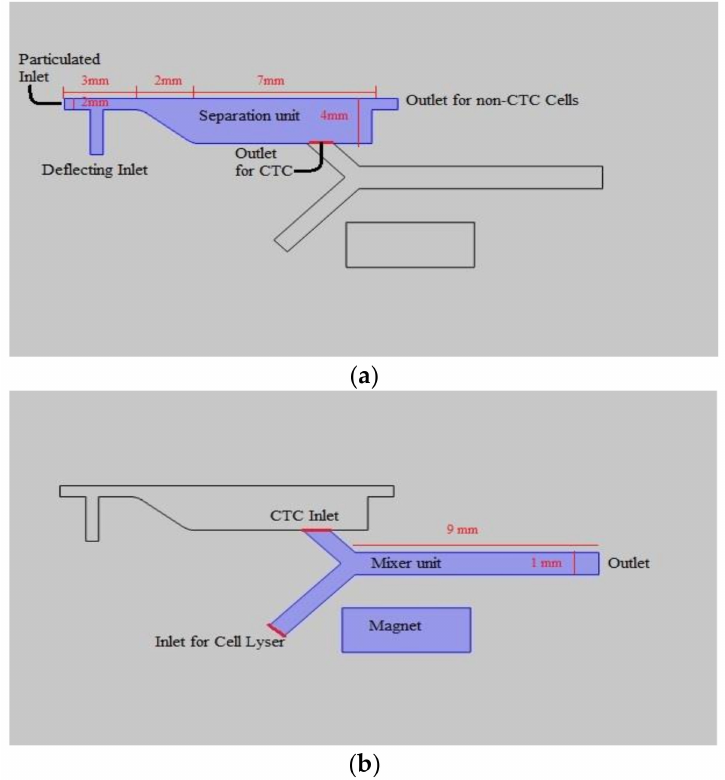
Figure 2. Top view of the geometry: ( a ) Section devised for isolating CTCs, composed of diverging section with 12 mm long in total composed of a 0.5 mm width inlet along with ancillary channel ending up to two distinct outlet one for tagged and one for non-tagged cells; and ( b ) Y-shaped section envisioned as mixing